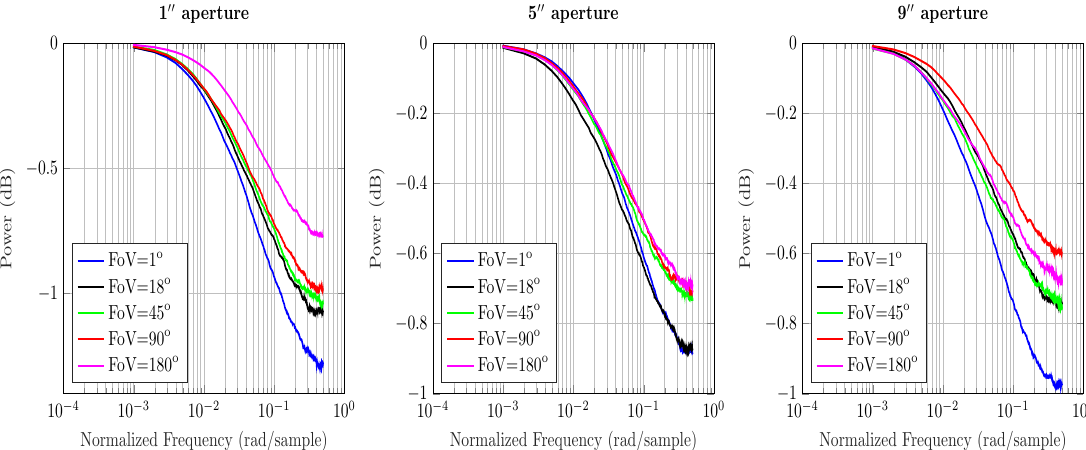
Figure 4. Comparison of the magnitude response of coastal water under various aperture sizes and FoVs for a 3 m LoS